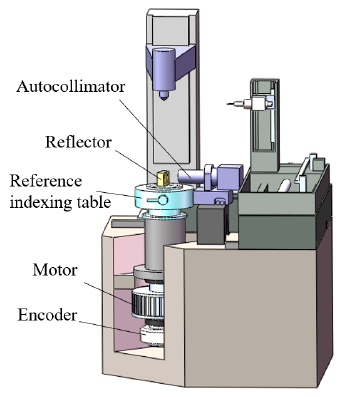
Figure 9. Measurement of the angular indexing error of the spindle.